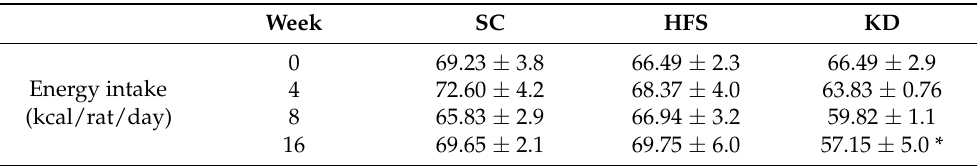
Table 1. Energy intake at weeks 0, 4, 8, and 16 in the SC-, HFS-, and KD-fed